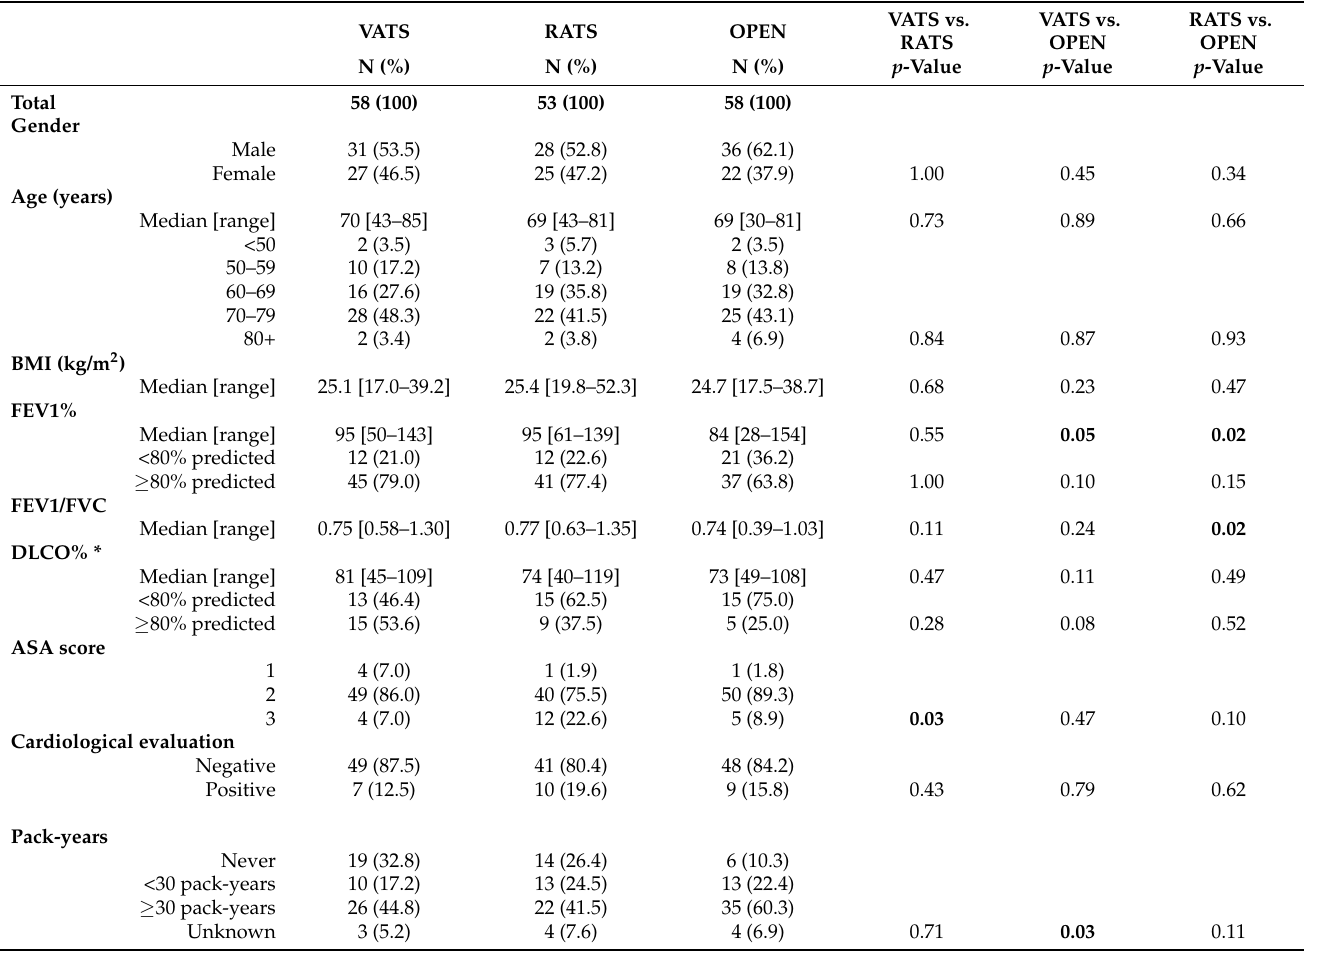
Table 1. Baseline patient characteristics in the three intervention groups before matching. VATS RATS OPEN